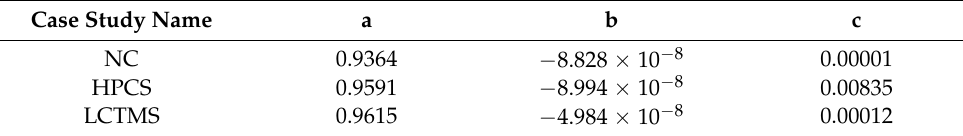
Table 5. The parameters of the exponential equation for curve